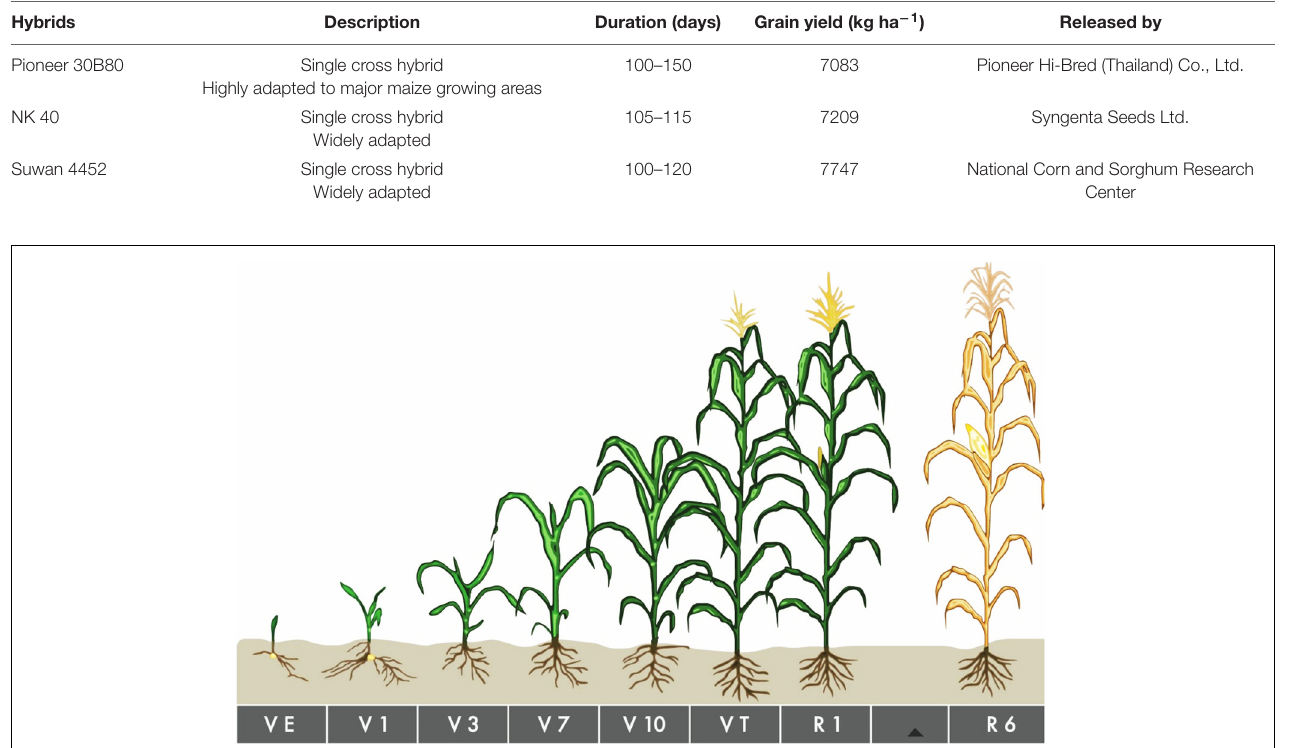
TABLE 1 | Characteristics of maize hybrids used in Expt. 1 and 2. [Source: National Corn and Sorghum Research Center, Thailand (2010)].